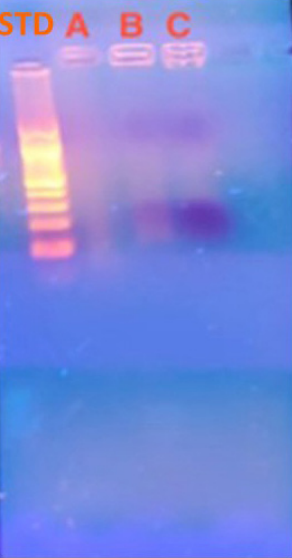
Figure 3. Two percent Agarose gel electrophoresis: (STD) DNA standards of different molecular weight, (A) CS/hsDNA microparticles, (B) CS/hsDNA in the presence of DNAse I, (C) CS/hsDNA in the presence of inactivated DNAse I.